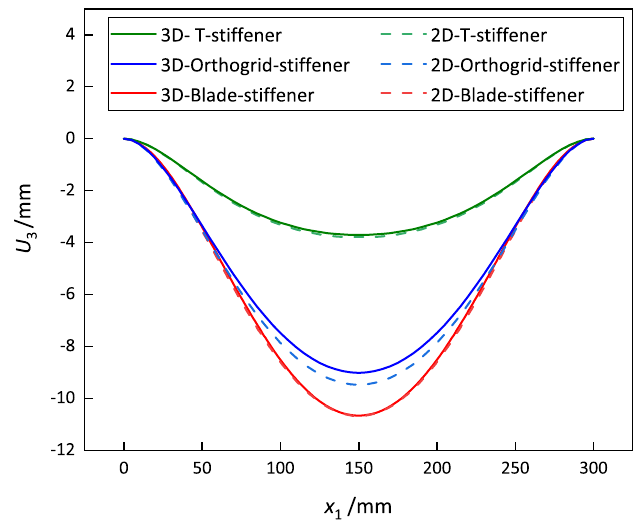
Figure 18. Comparison of the displacements along the center line of the stiffened FRP panel with different stiffening forms under the CCCC boundary condition and a 5 kPa uniform load.